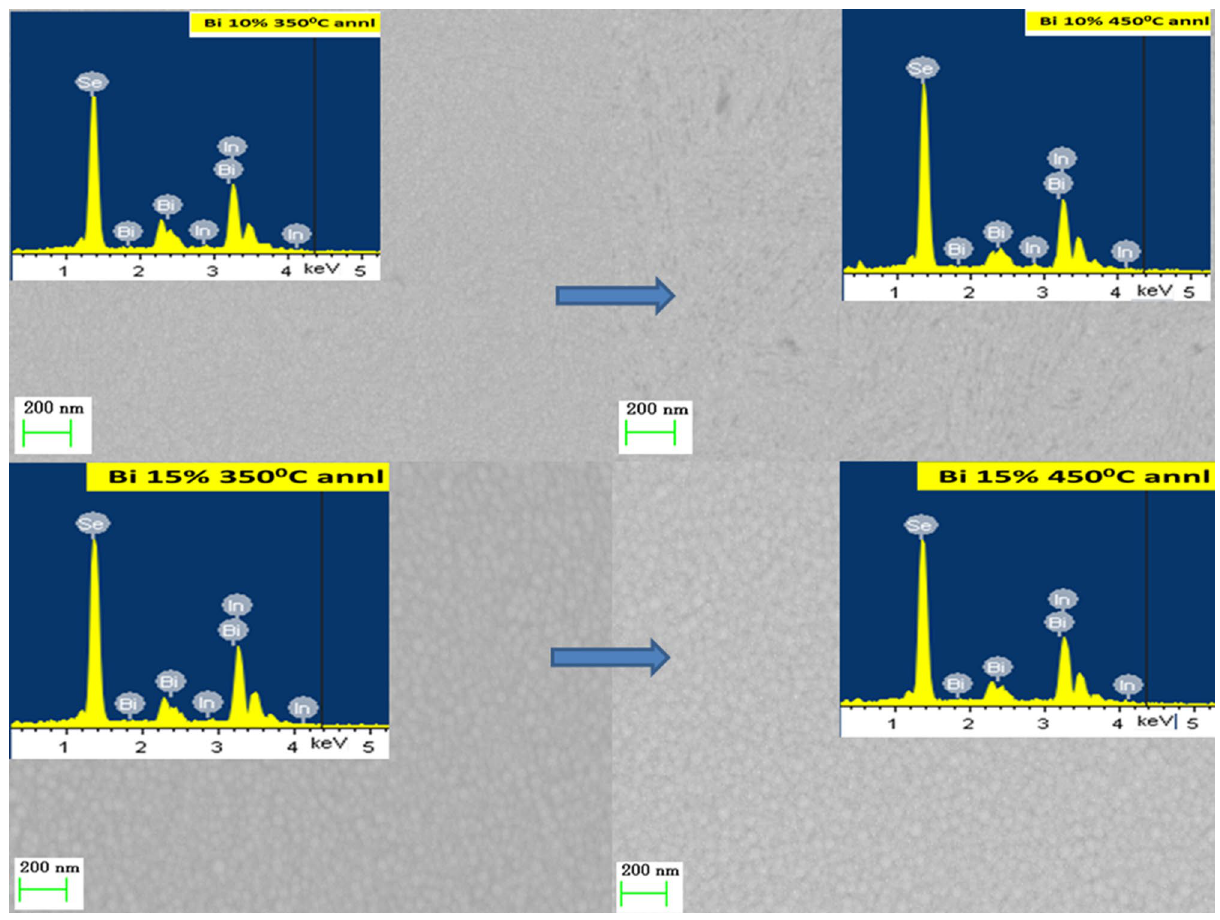
Figure 3. FESEM images of 350 °C and 450 °C annealed Bi 10 In 25 Se 65 and Bi 15 In 20 Se 65 thin films.